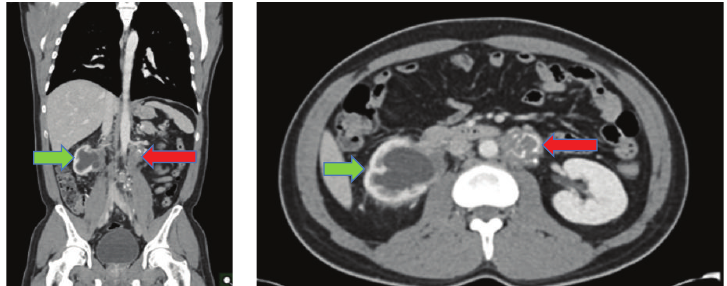
Figure 4: CT scan obtained 8 months after presentation status postchemotherapy showing reduction in the soft tissue stranding and thickening of the right kidney (green arrows) as well as stability of the retroperitoneal lymph nodes (red